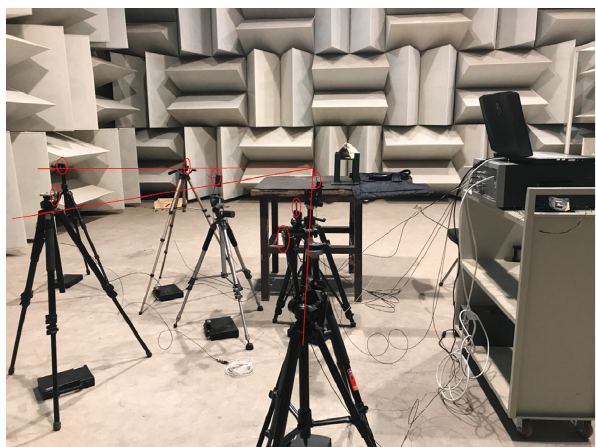
Figure 4: Experimental setup.